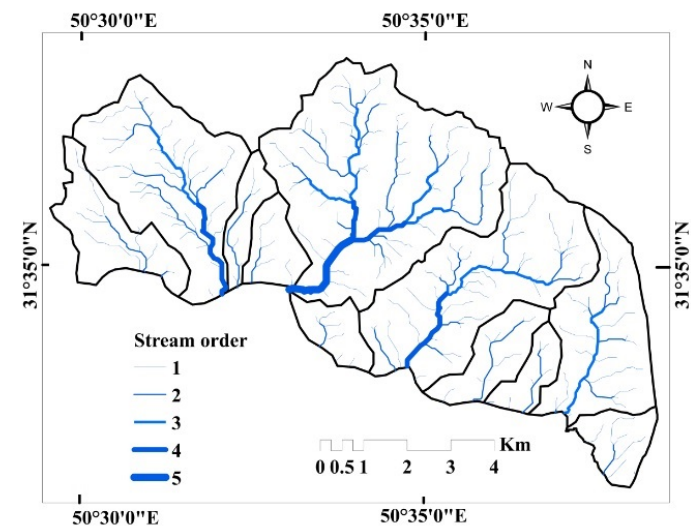
Figure 6. Stream order in the Kalv¯ar¯ı basin. Remote Sens. 2020 , 12 , x FOR PEER REVIEW